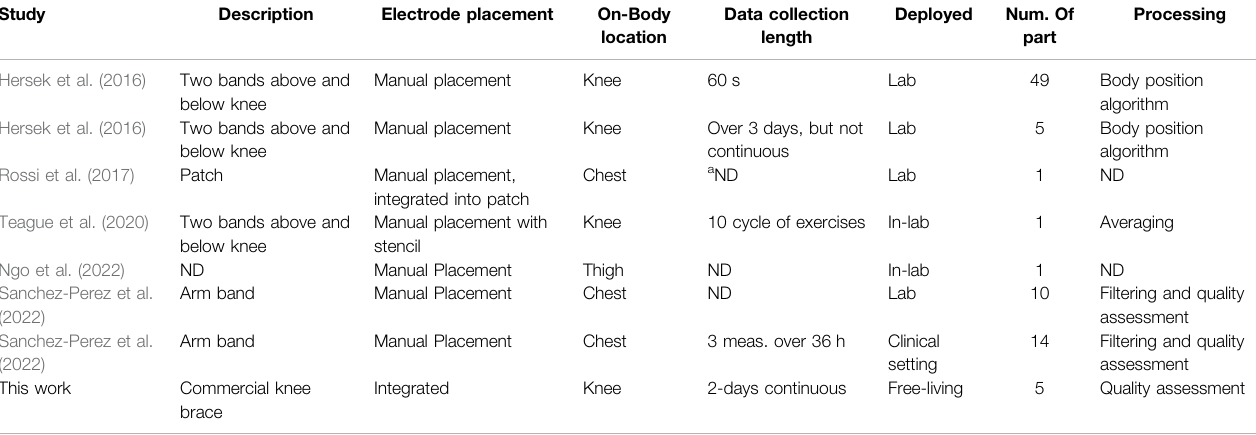
TABLE 5 | Wearable bioimpedance system comparisons from the